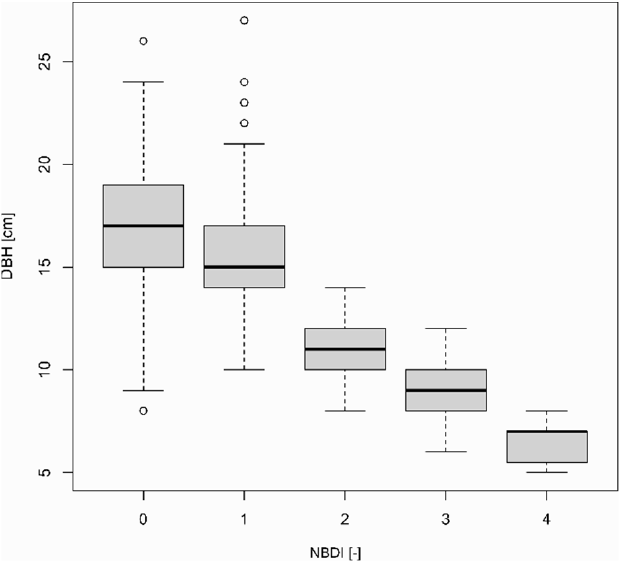
Figure 5. Median (horizontal line in box), the 25th percentile to the 75th percentile (box spans) and a ‘whisker’ ranging to maximum and minimum but no more than 1.5 times of the interquartile range (IQR) from the box top and bottom, respectively.